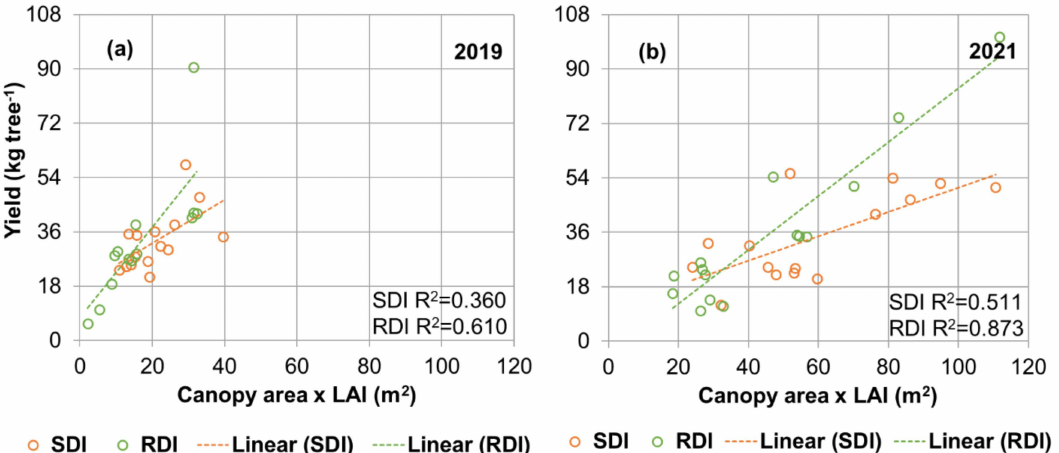
Figure 5. Yield of all 30 monitored trees in sustained (SDI) and regulated (RDI) deficit irrigation treat- ments in relation to canopy leaf area for 2019 ( a ) and 2021 ( b ). R 2 is the coefficient of